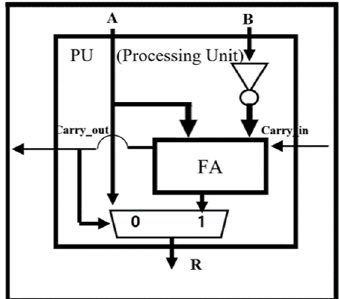
Figure 6. The Structure of processing unit for Signed Array division.